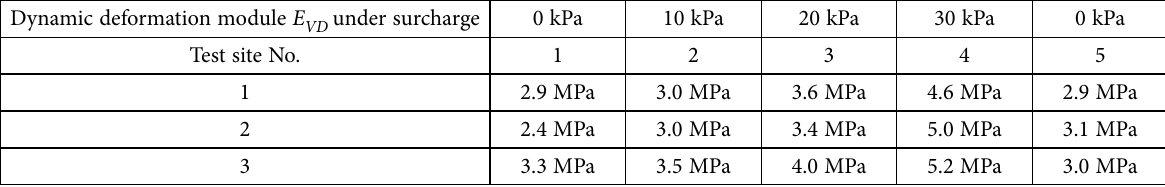
Fig. 7. Dynamic deformation module and surcharge dependence experimental data. 1, 2, 3 – test data from 1 st , 2 nd and 3 rd test site, 4 – mean values of dependency Table 2. Experiment data (Mikolainis